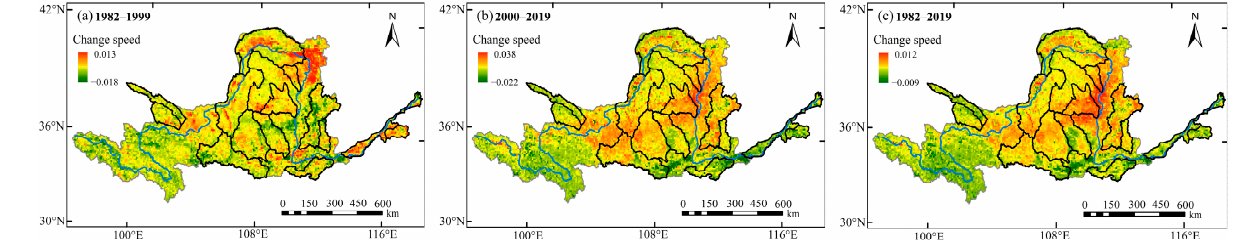
Figure 5. Spatial change speed patterns of three periods in the Yellow River Basin (YRB). Change speed: slope of linear fit over a period of time.